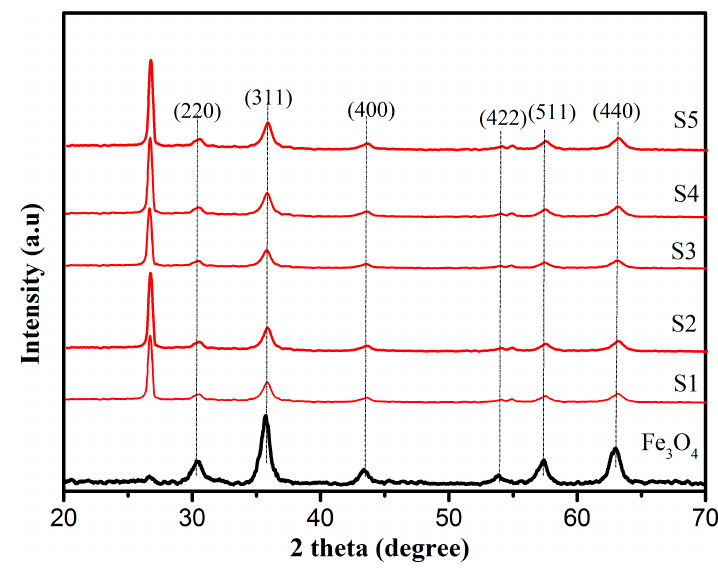
Figure 1. X-ray diffraction (XRD) patterns of Fe 3 O 4 , S1, S2, S3, S4, and S5. Figure 1. X-ray di ff raction (XRD) patterns of Fe 3 O 4 , S1, S2, S3, S4, and